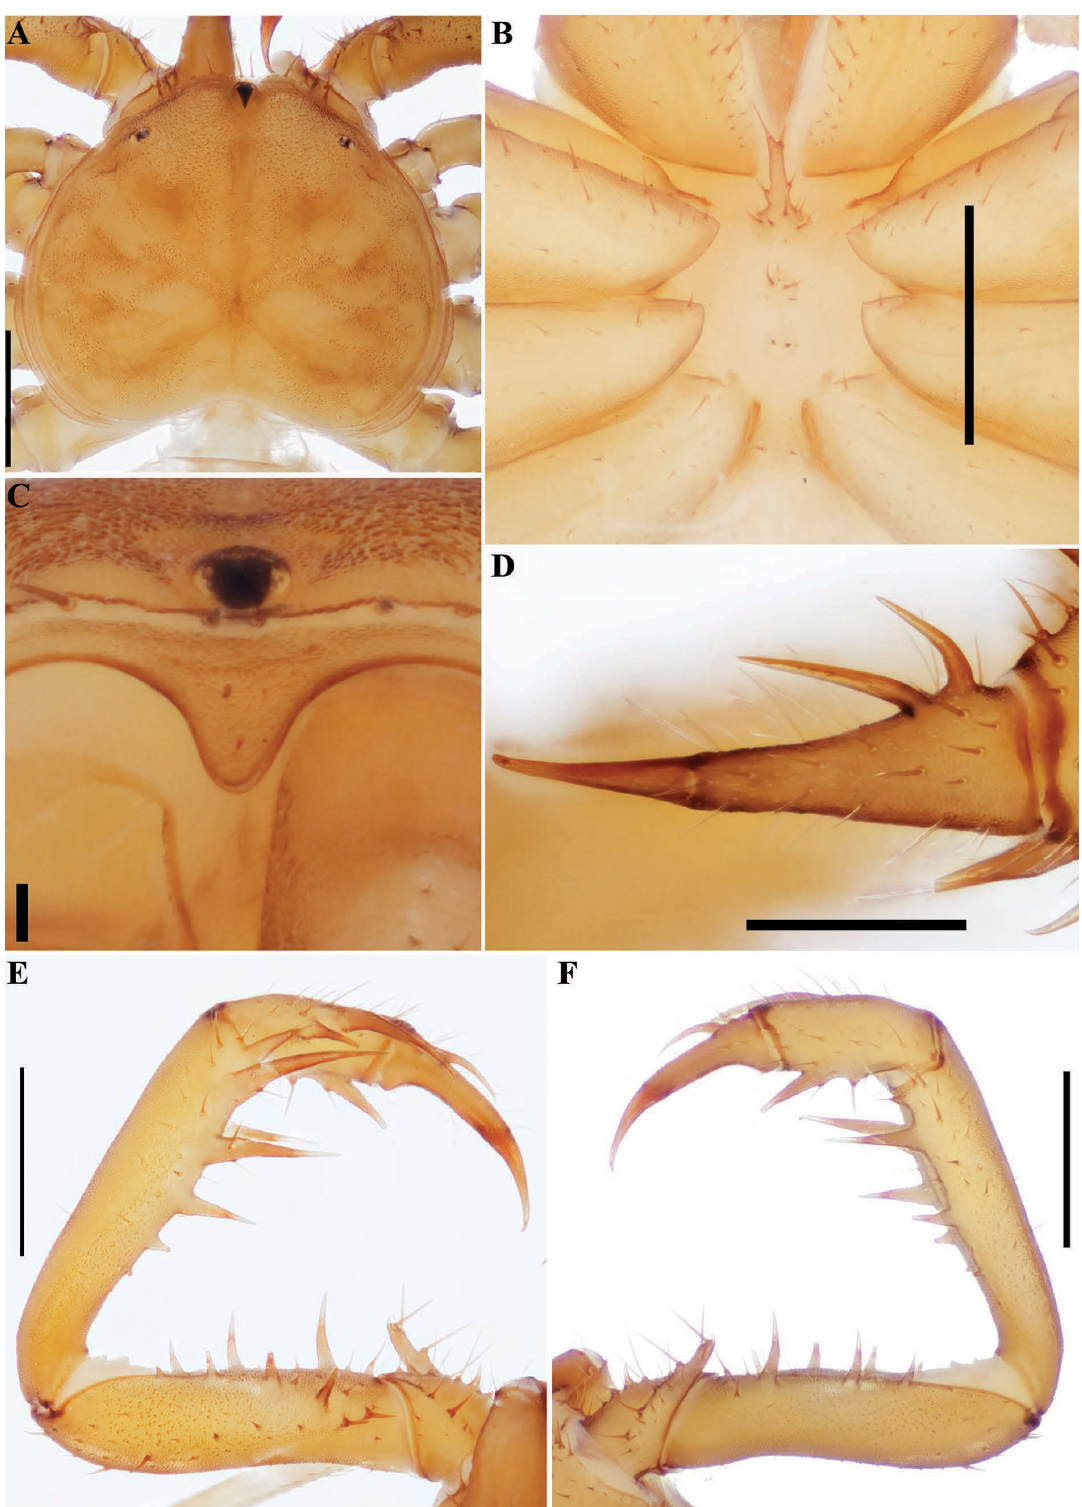
Fig. 144. Sarax pakistanus (Weygoldt, 2005) comb. nov. (MHNG), general morphology, ♂ . A . Carapace, dorsal view. B . Sternum, ventral view. C . Frontal process. D . Pedipalp tarsus, frontal view. E . Pedipalp, dorsal view. F . Pedipalp, ventral view. Scale bars: A–B, E–F = 1 mm; C = 0.1 mm; D = 0.5